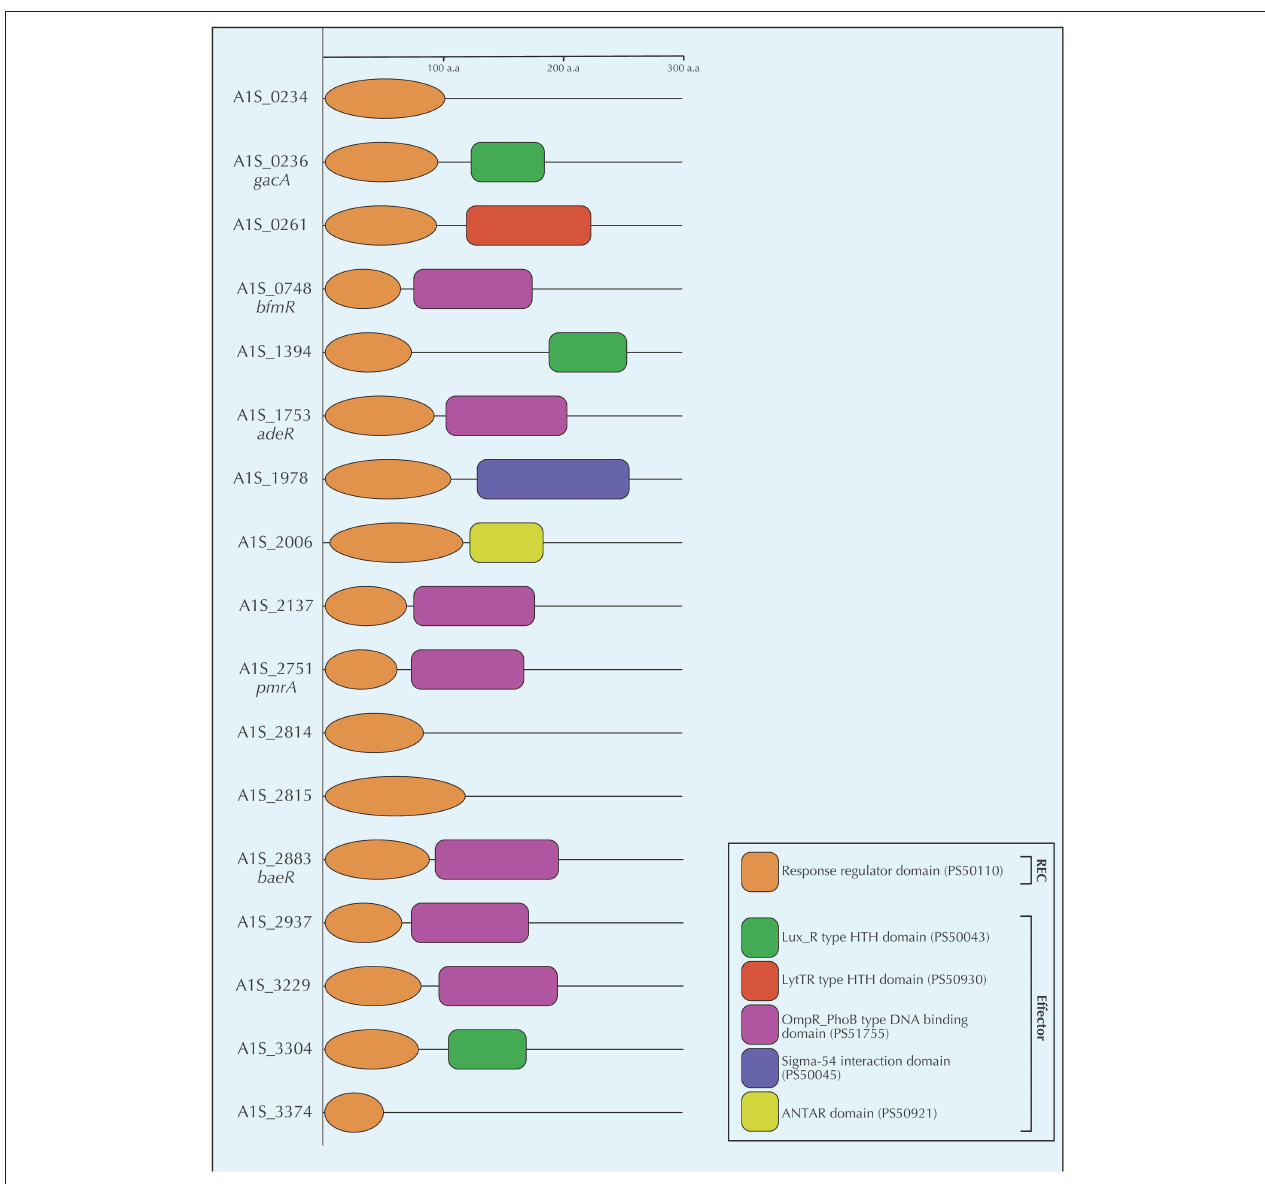
FIGURE 2 | Schematic diagram of the conserved domains of all the response regulators of A. baumannii ATCC17978 as determined by a ScanProsite (de Castro et al., 2006). The figure depicts the receiver domain (orange) and the different effector domains identified by ScanProsite (Lux_R type HTH domain in green, LytTR type HTH domain in red, OmpR_PhoB type DNA binding domain in violet, Sigma-54 interaction domain in purple, and ANTAR domain in yellow). Most abundant effector domain was the OmpR_PhoB type DNA binding domain which was present in seven response regulators followed by the Lux_R type HTH domain which was present in three response regulators. The other three types of effector domains were exclusive to single response regulators. The numbers in parenthesis refer to the PROSITE accession numbers of the respective domains. The hybrid sensor kinase A1S_2811 was not included in the figure due to the lack of a distinct response regulator